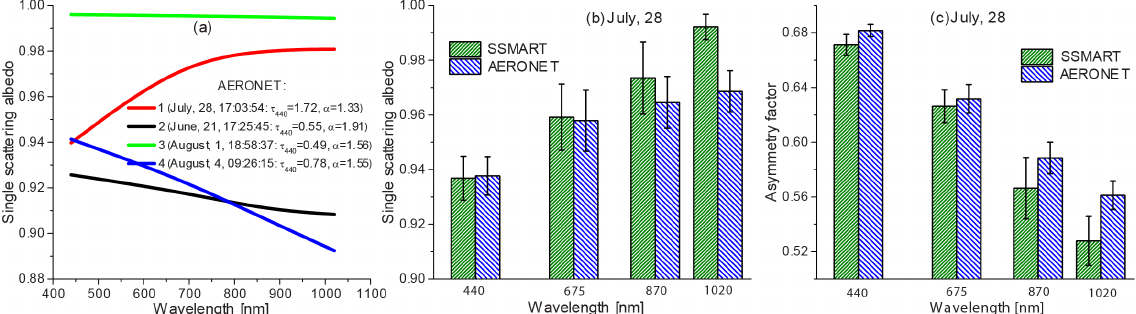
Figure 11. (a) Examples of spectral dependence of single scattering albedo (Dubovik and King, 2000), and diurnally averaged spectral variations of SSMART- and AERONET-derived (b) single scattering albedo and (c) asymmetry factor for 28 July 2012; error bars indicate the standard